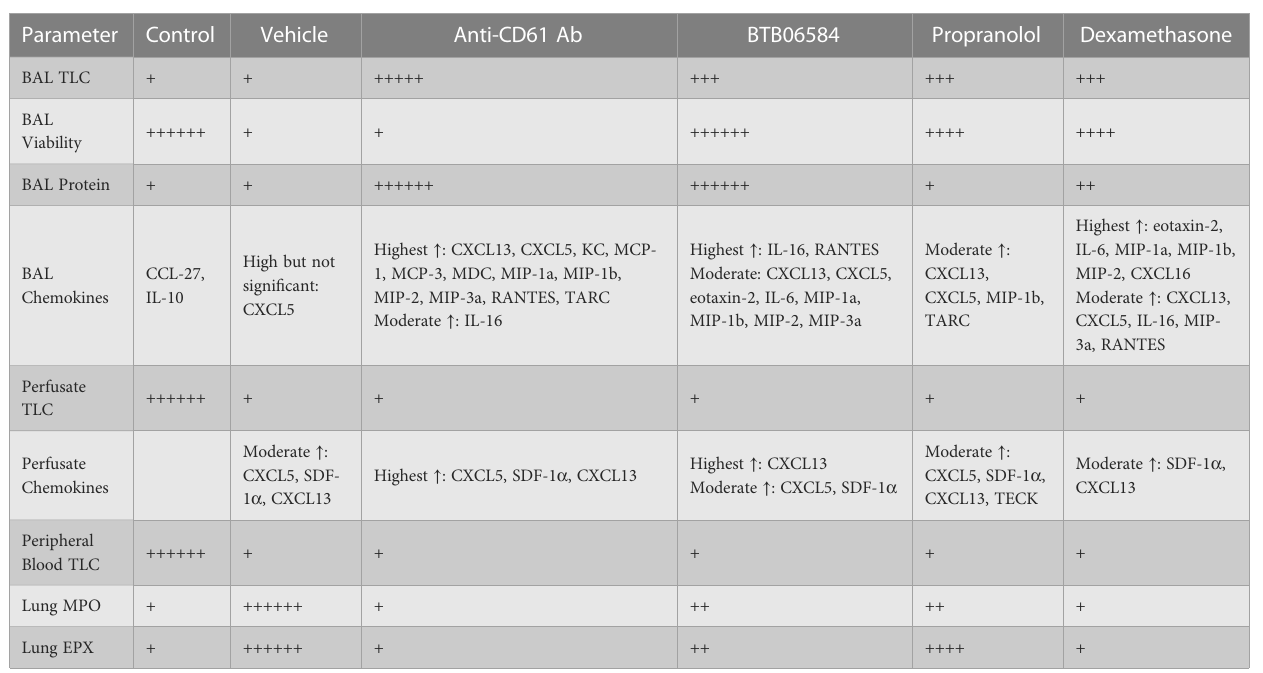
TABLE 1 Comparison of the main parameters, namely bronchoalveolar lavage (BAL) total leukocyte counts (TLC), BAL viability, BAL protein, BAL chemokines, lung vascular perfusate TLC, perfusate chemokines, peripheral blood TLC, lung myeloperoxidase (MPO) and lung eosinophil peroxidase